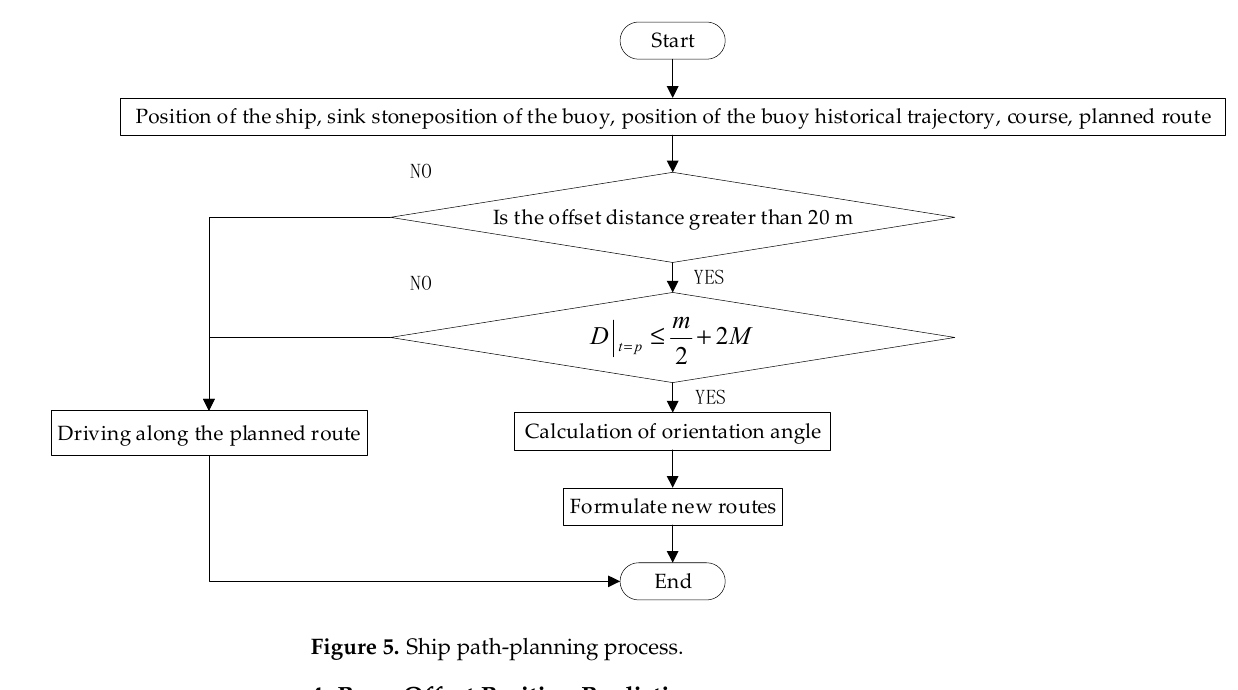
Figure 5. Ship path-planning process.